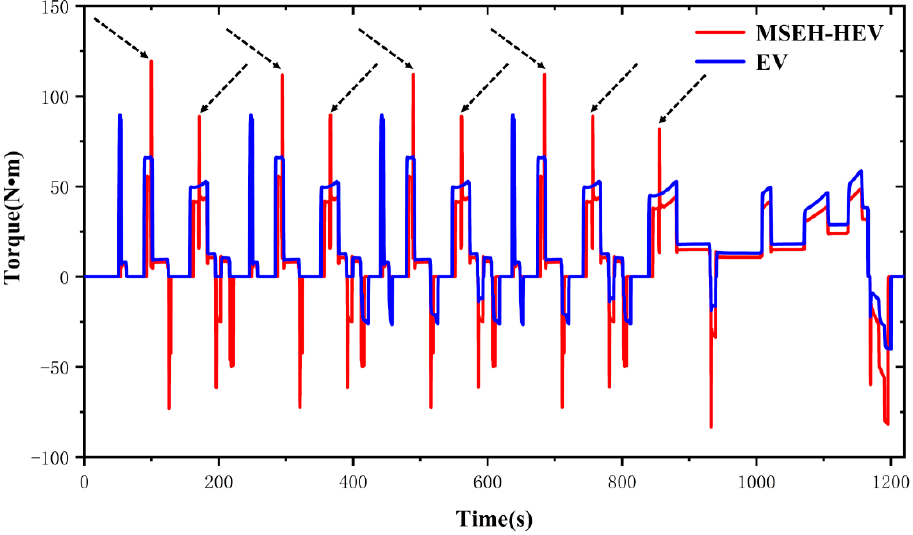
Figure 9. Motor torque curves.